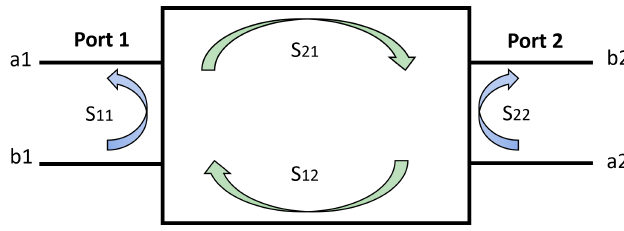
Figure 5. Identification of S-parameters in two-port